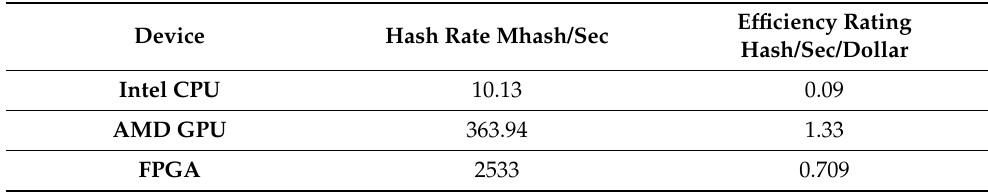
Table 1. Hash rate and efficiency rating